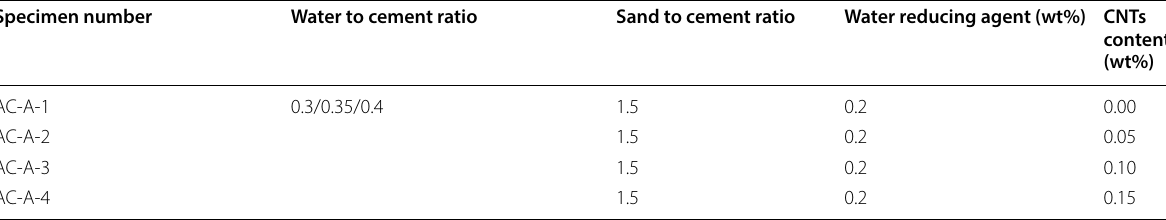
Table 6 Mixture proportions of different cement mortars with